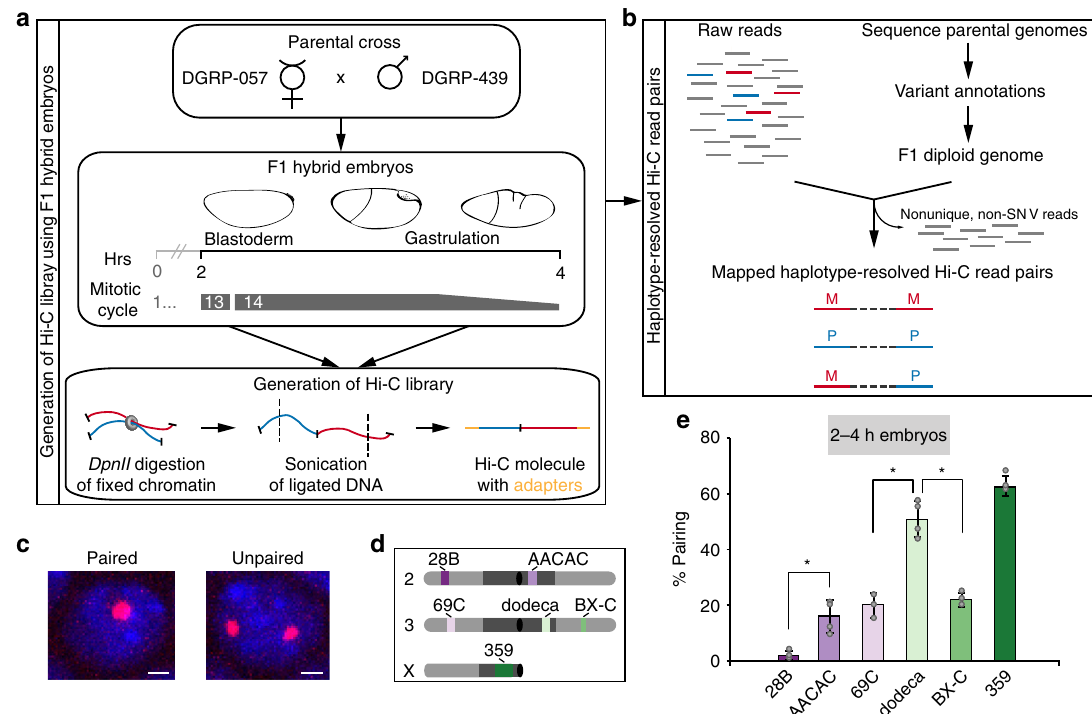
Fig. 1 Haplotype-resolved Hi-C to characterize embryonic homolog pairing. a Generation of Hi-C libraries using 2 – 4 h hybrid embryos and b haplotype- resolved mapping. c Homolog pairing as assessed by FISH. Nuclei are considered paired nuclei when FISH signals are ≤ 0.8 μ m (center-to-center distance) apart. Bar = 1 μ m. d Location of FISH targets (heterochromatin, dark gray; euchromatin, light gray; centromere, black circle). e Percentage of nuclei showing paired loci in 2 – 4 h embryos (error bars, standard deviation of at least three replicates; n ≥ 100 nuclei/replicate; * P < 0.0001, Fisher ’ s two-tailed exact). Source data are provided as a Source Data fi